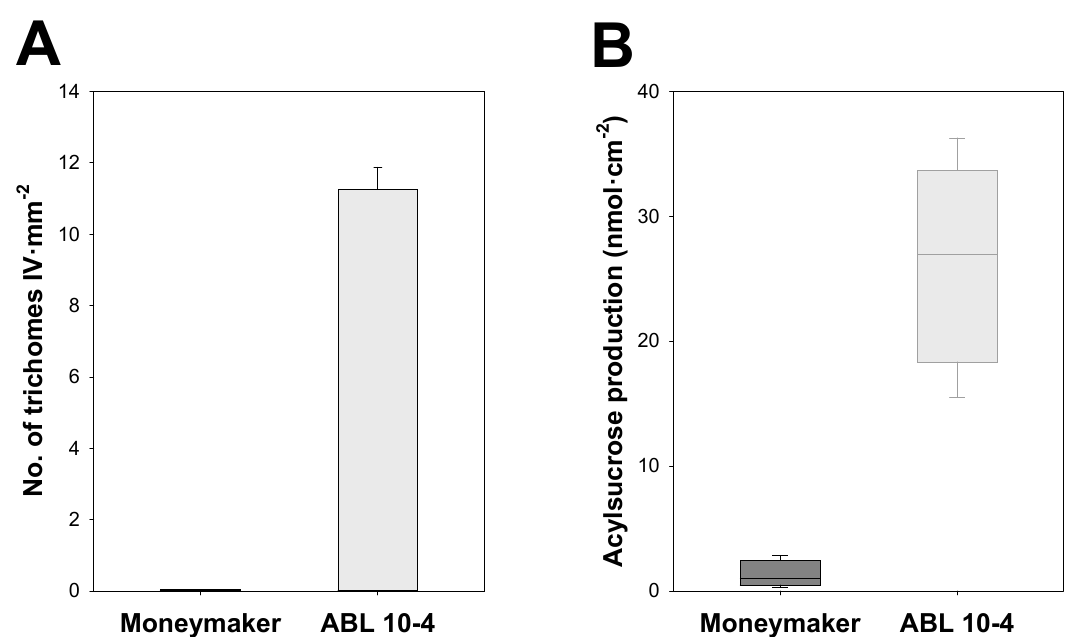
Figure 2. Type IV leaf trichome density and production of acylsucrose in Moneymaker and ABL 10-4 near-isogenic tomato lines. ( A ) Bar graph showing type IV leaf glandular trichome density on abaxial leaflet surfaces of Moneymaker and ABL 10-4 plants at the ten-leaf growth stage. ( B ) Box-and-whisker plots showing acylsucrose accumulation on leaflets of Moneymaker and ABL 10-4 plants at the ten-leaf growth stage; the box represents the interquartile range, the horizontal line in the box shows the value of the median, and bars mark the 10th and 90th percentiles.